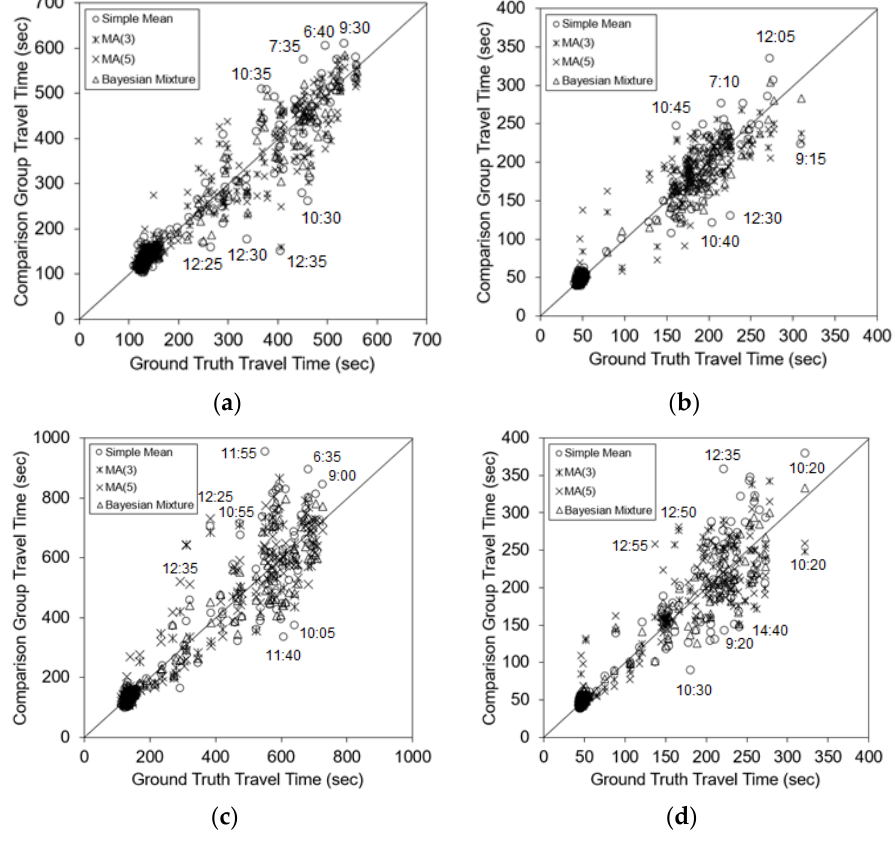
Figure 3. Scatter plot between ground truth and comparison groups: ( a ) Case I, 29 April 2017, ( b ) Case II, 29 April 2017, ( c ) Case I, 5 May 2017, ( d ) Case II, 5 May 2017.